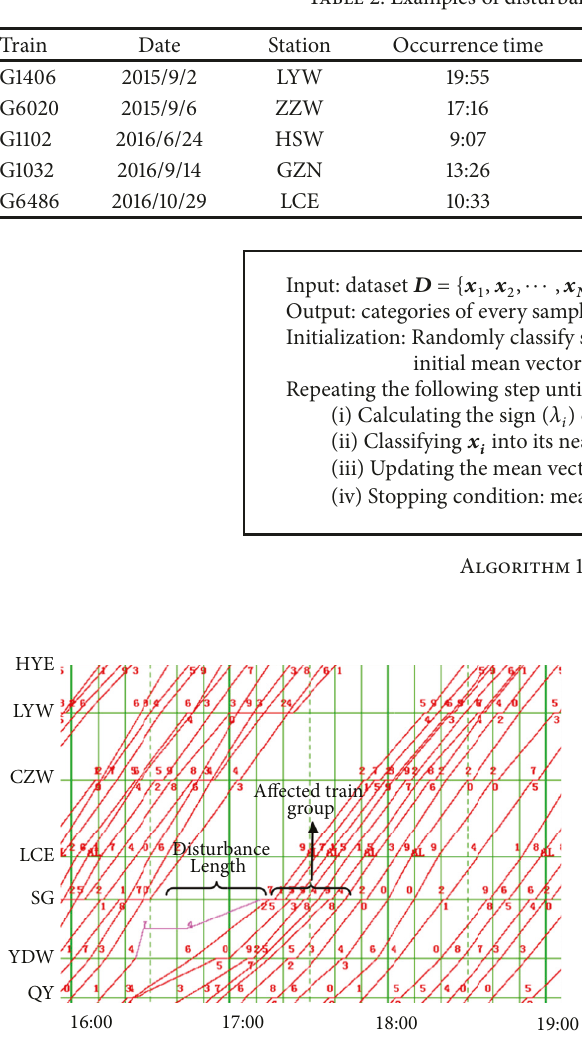
Figure 4: A real disturbance happened on W-G HSR line shown in time-space diagram (horizontal axis is time, and vertical axis is